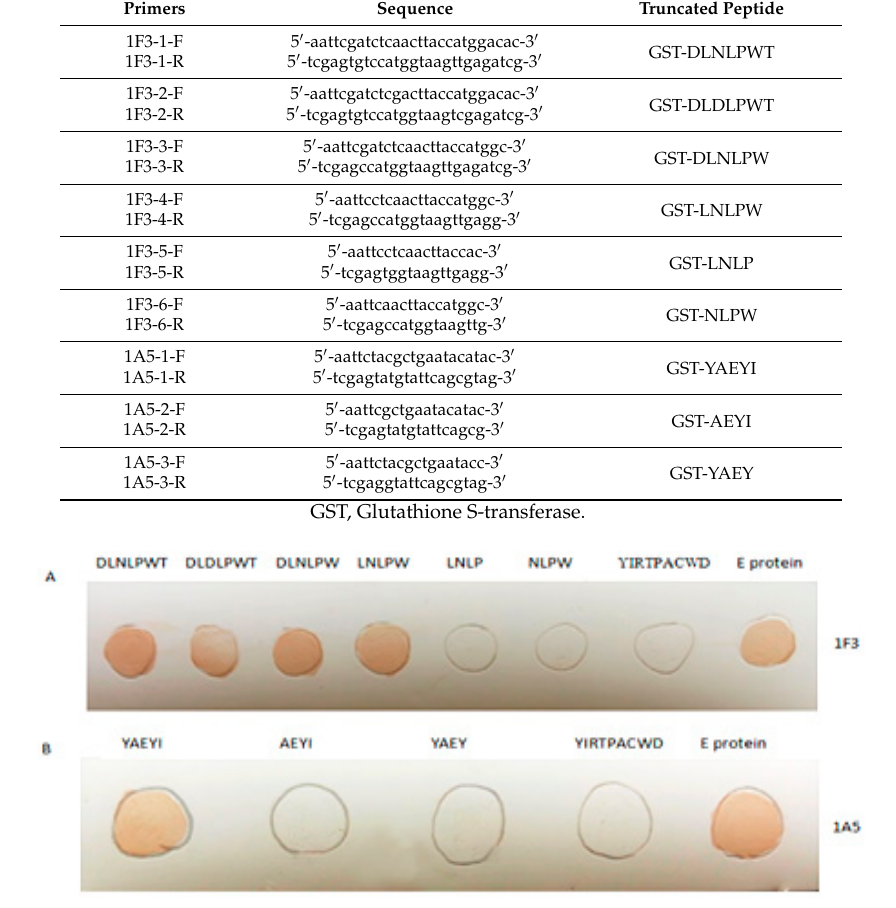
Figure 2. Identification of the E protein epitopes based on mAbs IF3 ( A ) and 1A5 ( B ) reactivity with the synthesized peptides in the dot blotting assay. YIRTPACWD and the E protein were used as the negative and positive control, respectively.